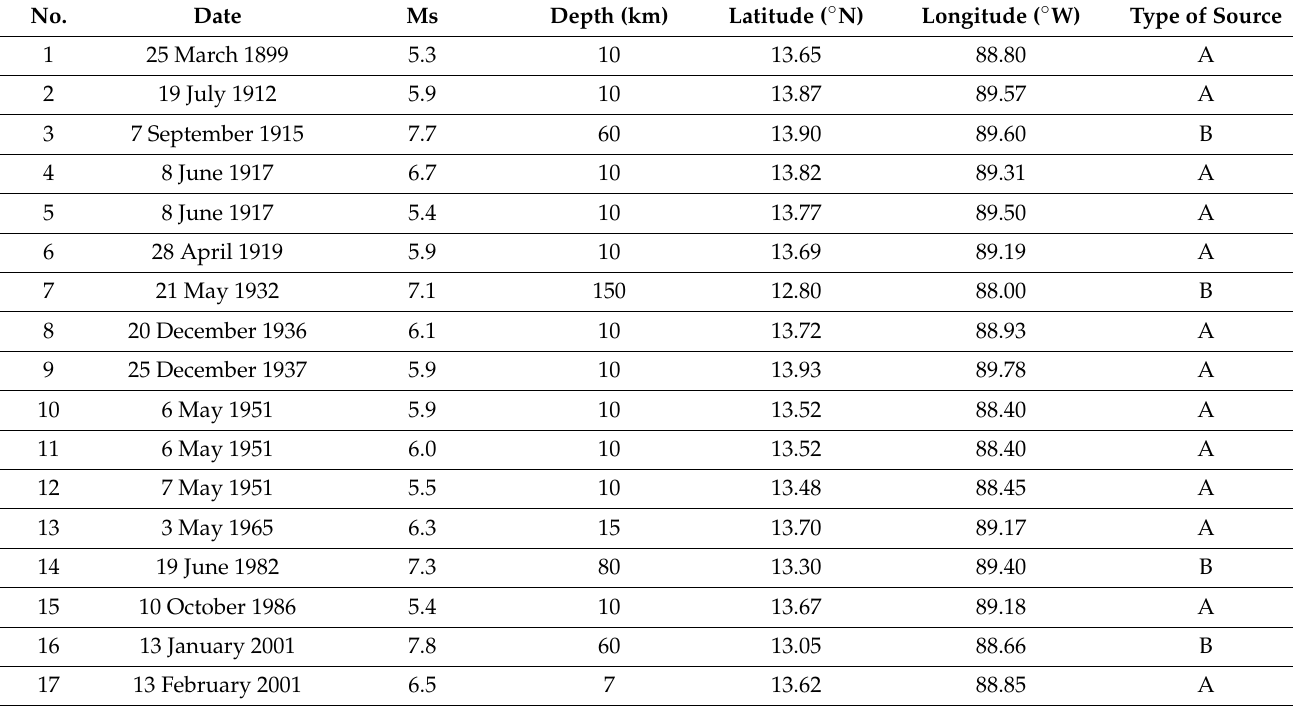
Table 1. Seismological parameters for destructive earthquakes in El Salvador region since 1899. A: Volcanic chain ; B: Subduction zone . Modified from